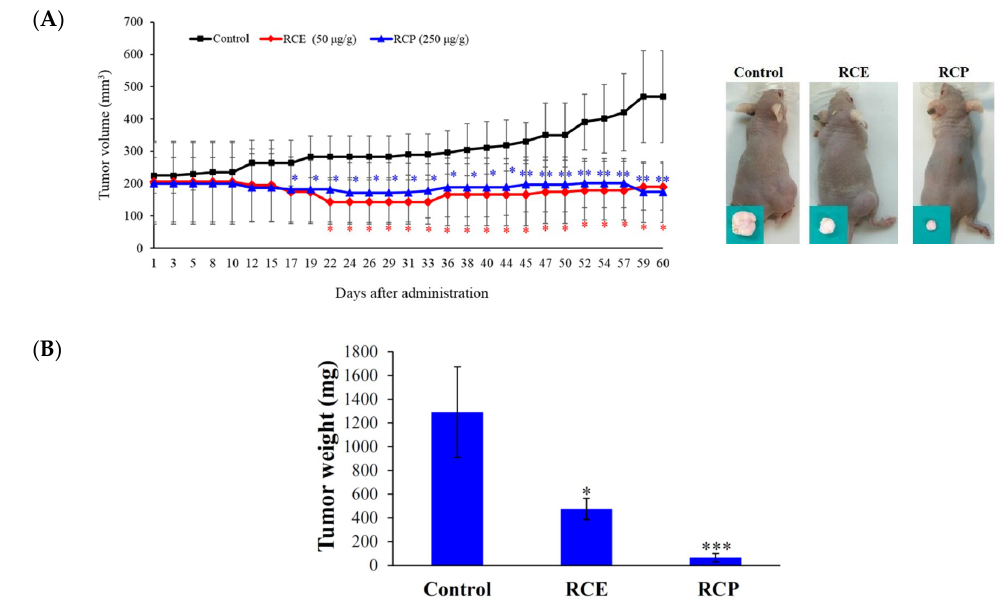
Figure 2. Effect of RCE on tumor growth in the in vivo xenograft animal model. ( A ) RCE and fruit powder of R. cymosa (RCP) inhibited tumor growth in the in vivo xenograft animal model inoculated with human leukemia Molt-4 xenograft. Male nude mice bearing leukemia Molt-4 tumors were treated with the solvent (negative control, n = 10), RCE (50 µg/g, n = 10), or RCP (250 µg/g, n = 10) for 60 days. Tumor volumes were measured every other day, and the results are expressed as mean ± SD. ** Significantly different from the control groups at p = 0.0053. Representative photos of subcutaneous tumors, which were collected after treatment with the solvent only (right), with RCE (middle), or RCP (left) after 60 days; ( B ) Histogram of the tumor weight from the control group and RCE-treated group. Values are expressed as the mean ± SD. Significantly different from the control group at * p < 0.05; *** p < 0.001.